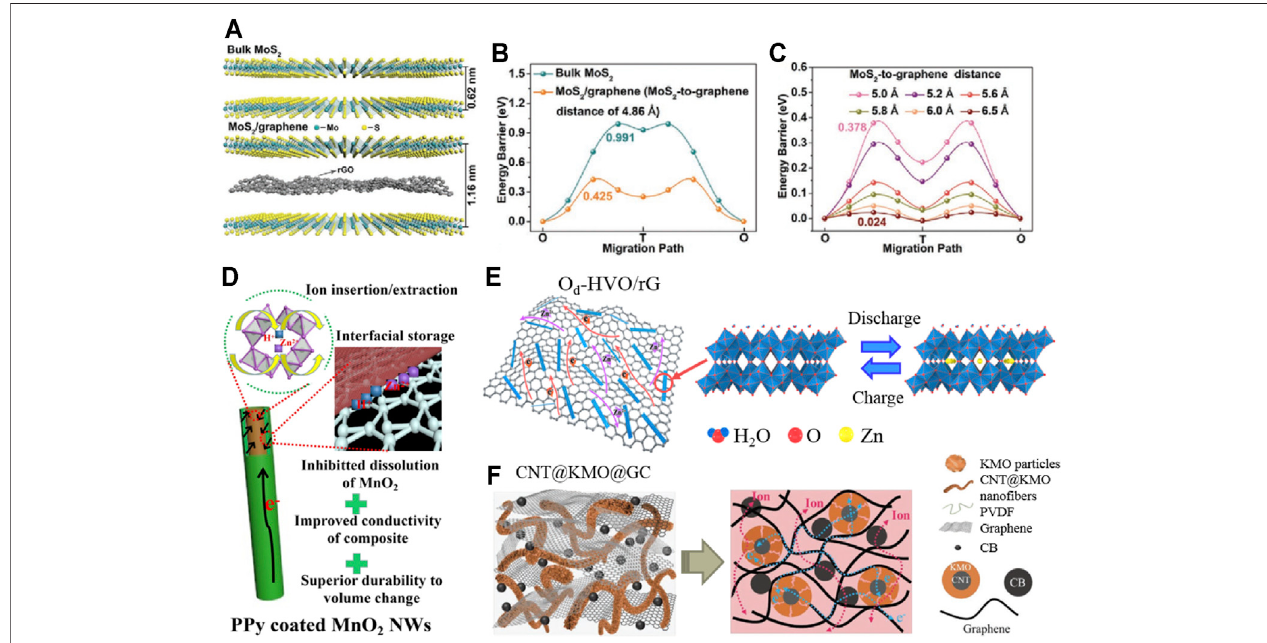
FIGURE 2 | Structural modi fi cation and composite of cathode materials: (A) Crystal structures of bulk MoS 2 and MoS 2 /graphene; (B,C) the corresponding migration energy barriers withthe variation ofthe MoS 2 -to-graphene distance; (D) schematic illustration offreestandingCNT/MnO 2 -PPy; (E) schematic diagram of Zn 2+ (de)intercalating mechanism in O d -HVO/rG; (F) illustration of electron/ion transport and ion diffusions across the electrodes of CNT@KMO@GC. Reproduced with permission (Zhang et al., 2020a; Li et al., 2021d; Huang et al., 2021; Wang et al., 2021).